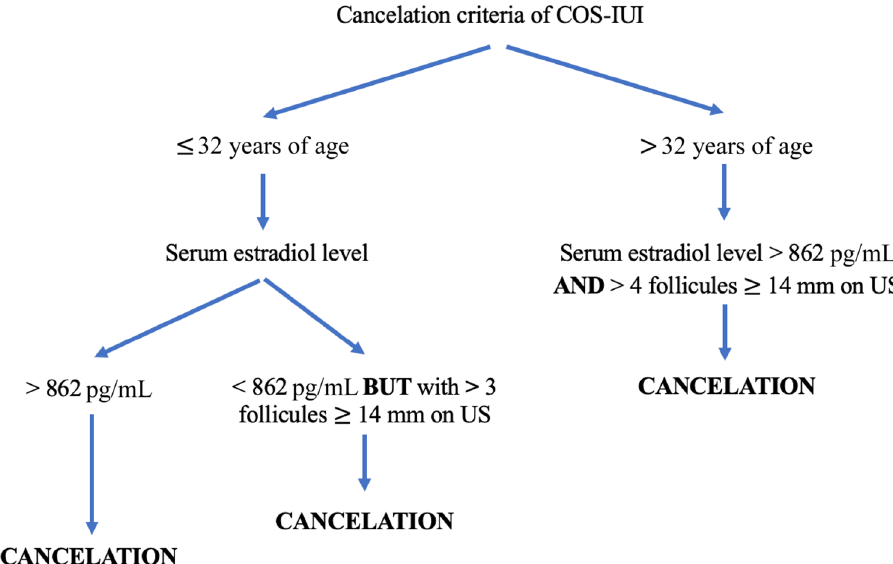
Figure 3. Algorithm for cycle cancelation in cases of excessive response to stimulation (inspired by Tur et al .